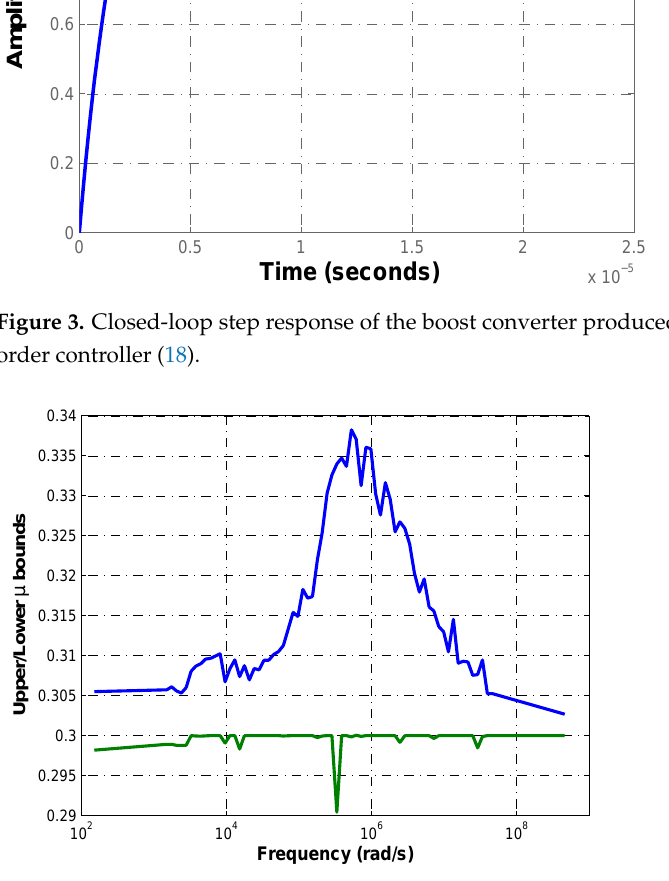
Figure 4. Upper/lower bounds for structured singular value µ ∆ to investigate the closed-loop robustness in the presence of parameter